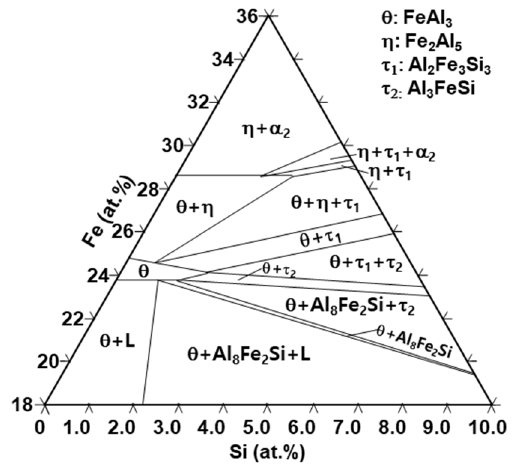
Figure 15. Portion of Fe–Al–Si Phase diagram calculated by Thermo ‐ Calc™.